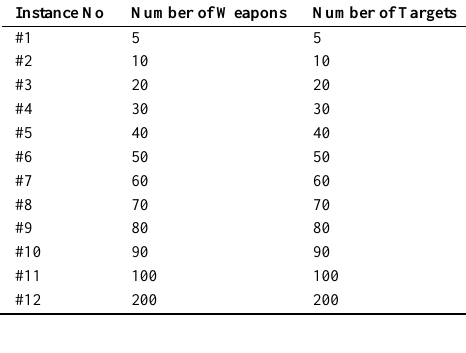
Table 2. The WTA problem instances.